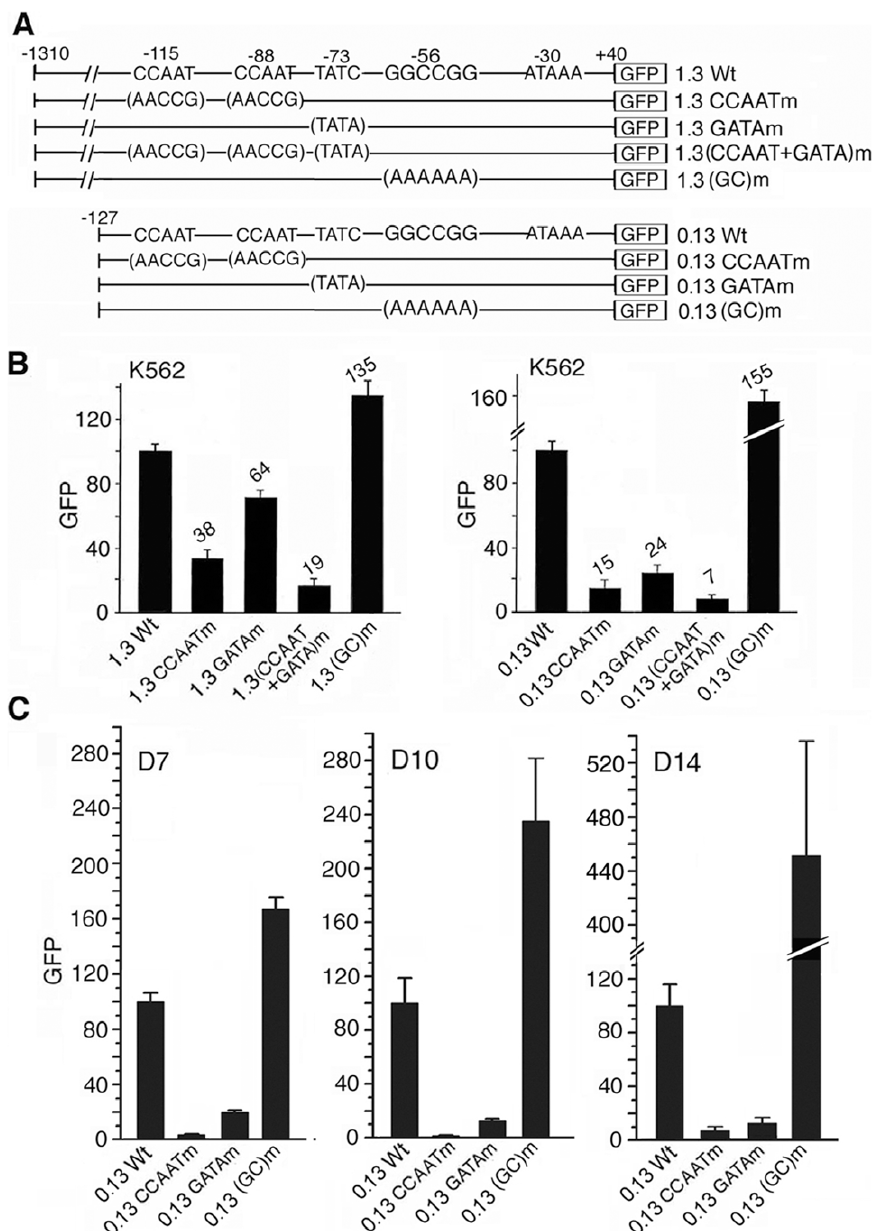
Figure 2. Function of the tandem CCAAT, GATA and GGCCGG motifs in regulating proximal c -globin promoter activity, determined in GFP reporter plasmids by transfection/transduction assays. A. Plasmid maps of Wt and mutant long 1.3 kb and short, proximal 0.13 kb c - globin promoter coupled to GFP gene. Mutated bases in the motifs were shown in parentheses. B. Transfection into K562 cells of GFP plasmids containing the long and the short promoters, left and right panels respectively. Numbers on top of the bars: fluorescence levels of GFP expressed from the mutant plasmids compared to those from Wt plasmids set at 100. Values were averages of two independent transcfection experiments. C. Transduction into adult erythroid cells of recombinant lentiviruses containing the Wt and mutant proximal c -globin promoters coupled to GFP gene. Cells were transduced on day 3 and GFP fluorescence was determined on day 7, 10 and 14 of culture, as shown in the 3 panels respectively. The GFP level in control cells transduced with the wildtype 0.13 kb c -globin promoter-GFP lentivirus was set at 100. Values were averages of two